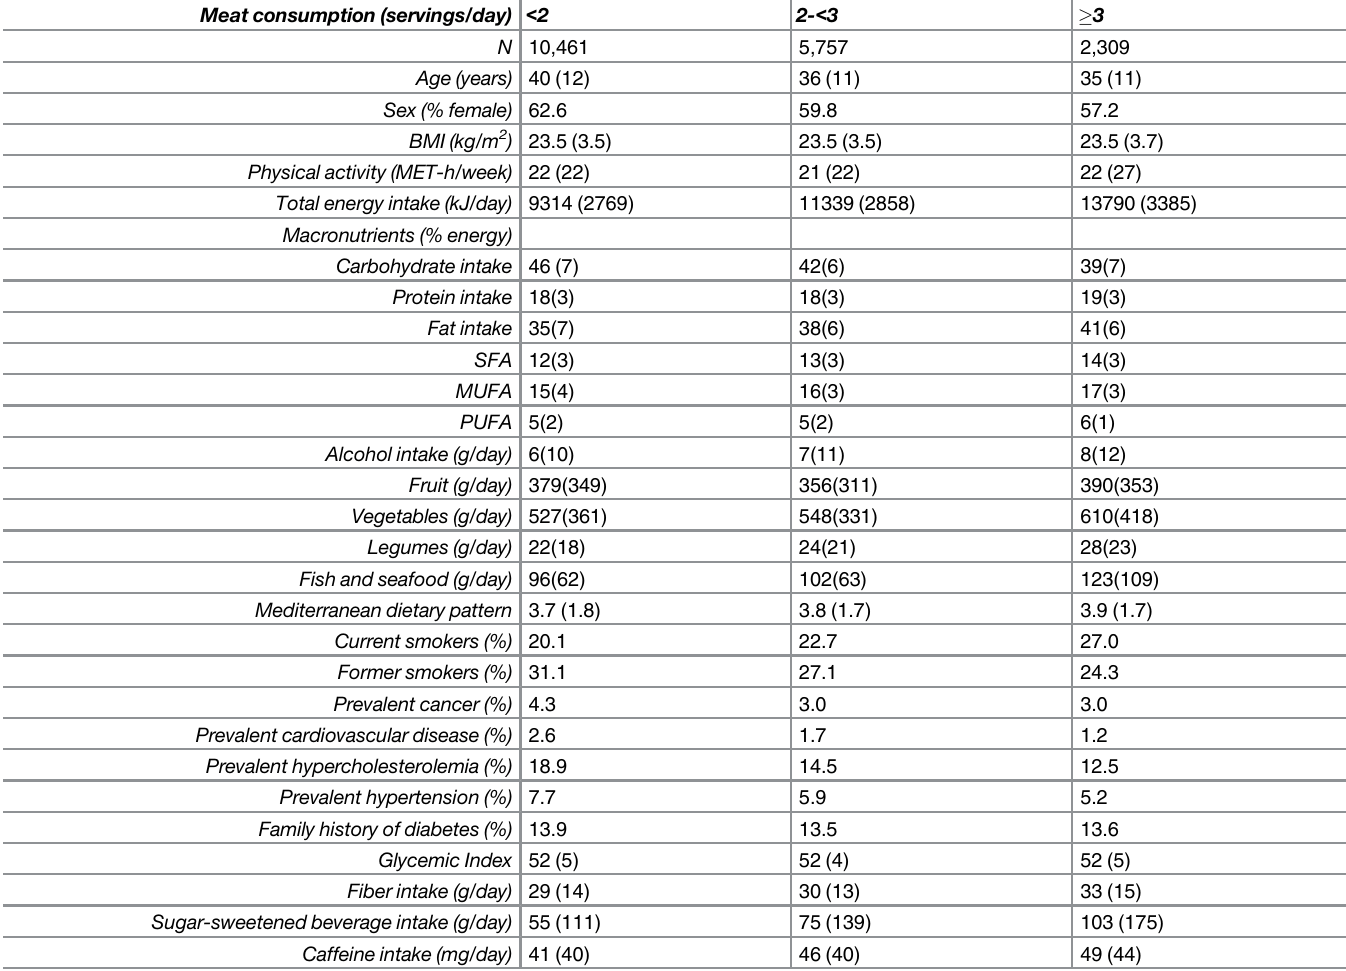
Table 1. Baseline characteristics according to categories of meat consumption (mean and SD, or %). The SUN Project 1999 – 2014.